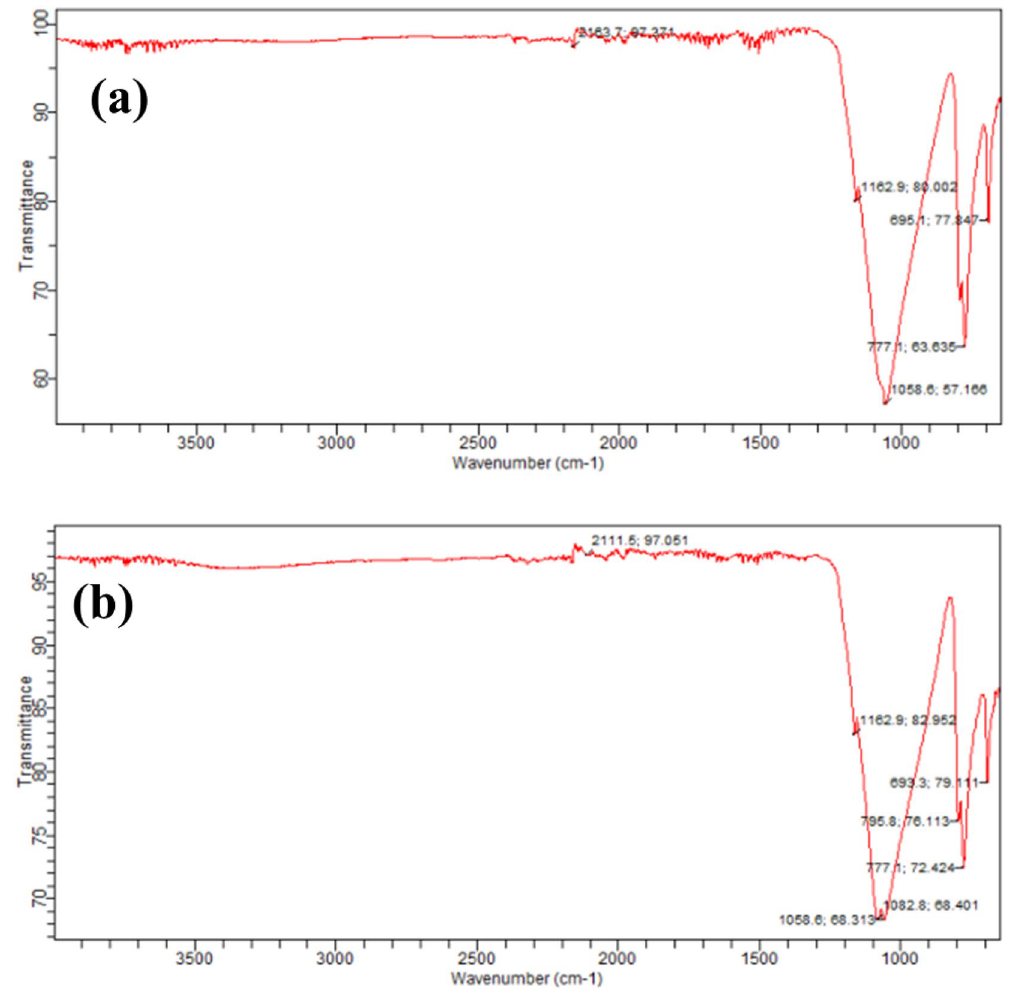
Figure 3. FTIR spectra of ( a ) Feldspar (catalyst support) ( b )